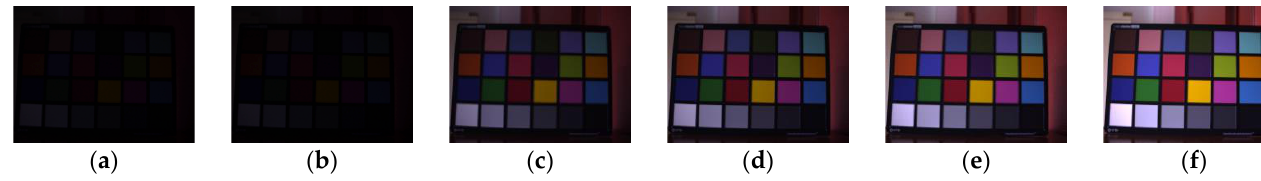
Figure 4. Color chart acquired at various exposure times. ( a ) image f 3 at 3 ms; ( b ) image f 6 at 6 ms; ( c ) image f 18 at 18 ms; ( d ) image f 24 at 24 ms; ( e ) image f 33 at 33 ms; ( f ) image f 45 at 45 ms.